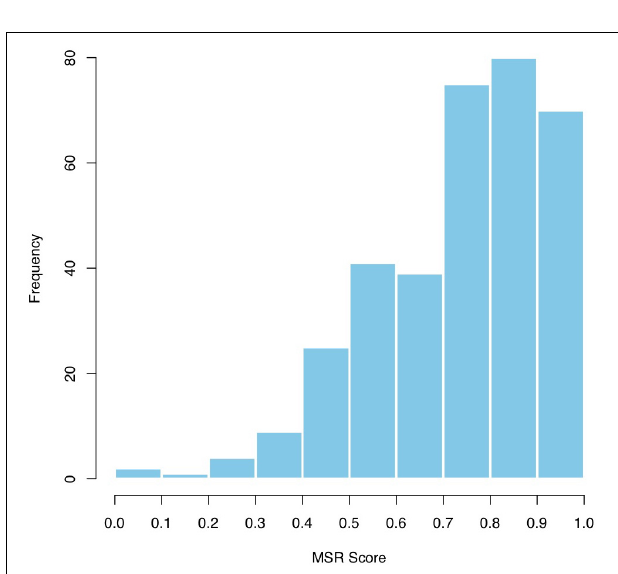
FIGURE 2 | Distribution of MSR score in the sample of the study ( n = 346).